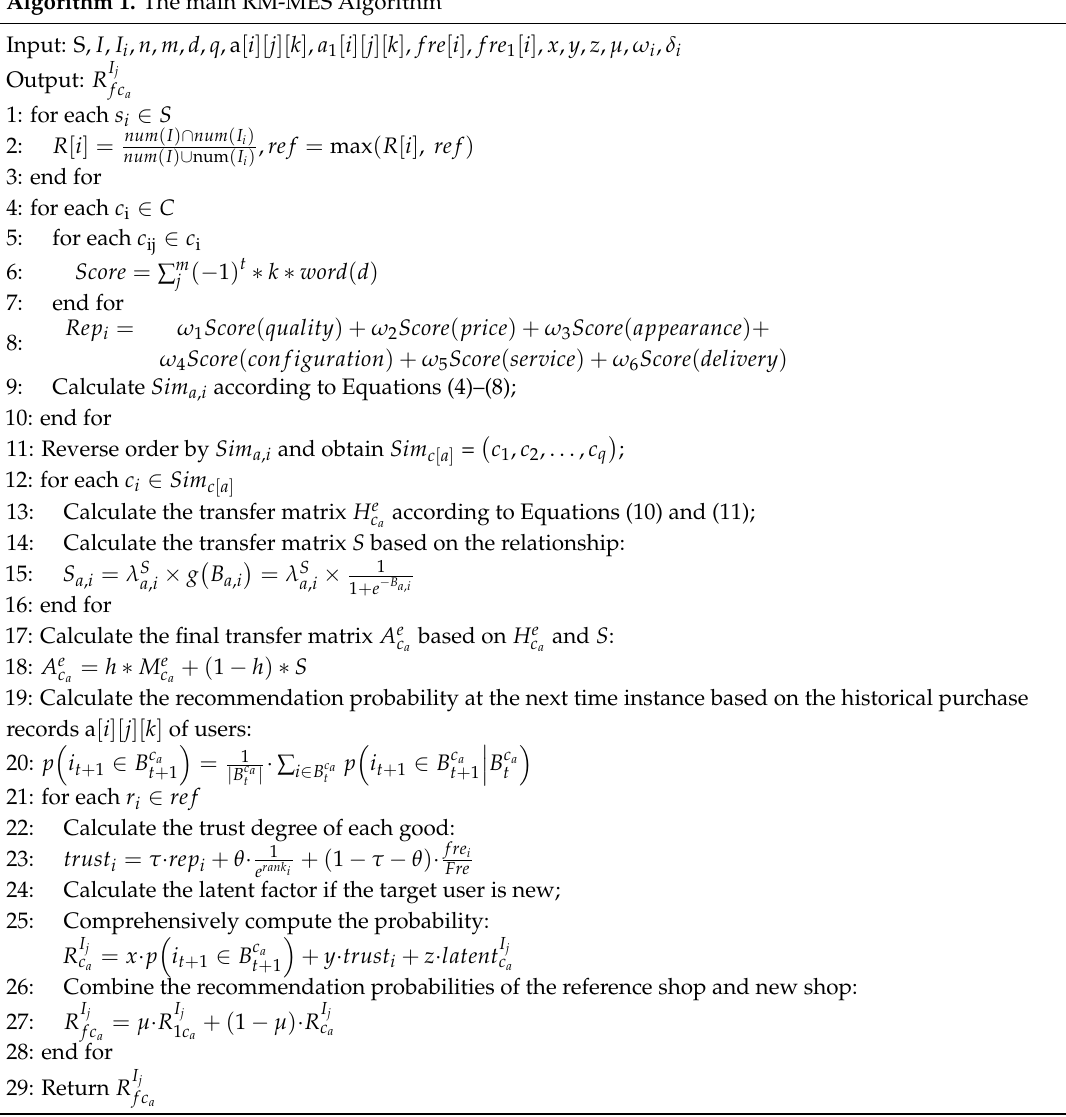
Algorithm 1. The main RM-MES